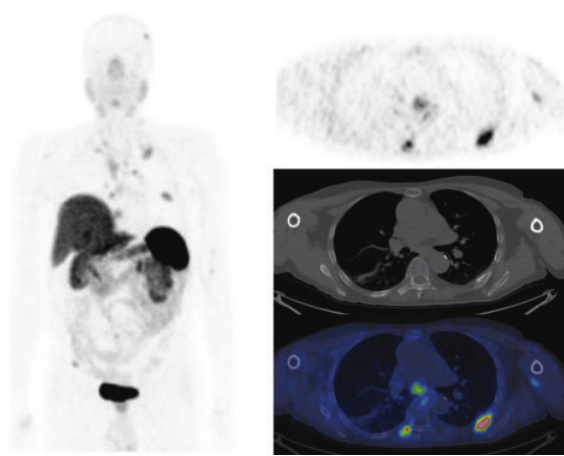
Figure 6: 68 Ga-DOTATATE PET/CT images (MIP, axial) in a patient affected by metastatic medullary thyroid carcinoma. to [ 18 F]FDG PET results. In this case 68 Ga-DOTATOC PET showed 50% of lesions evident at [ 18